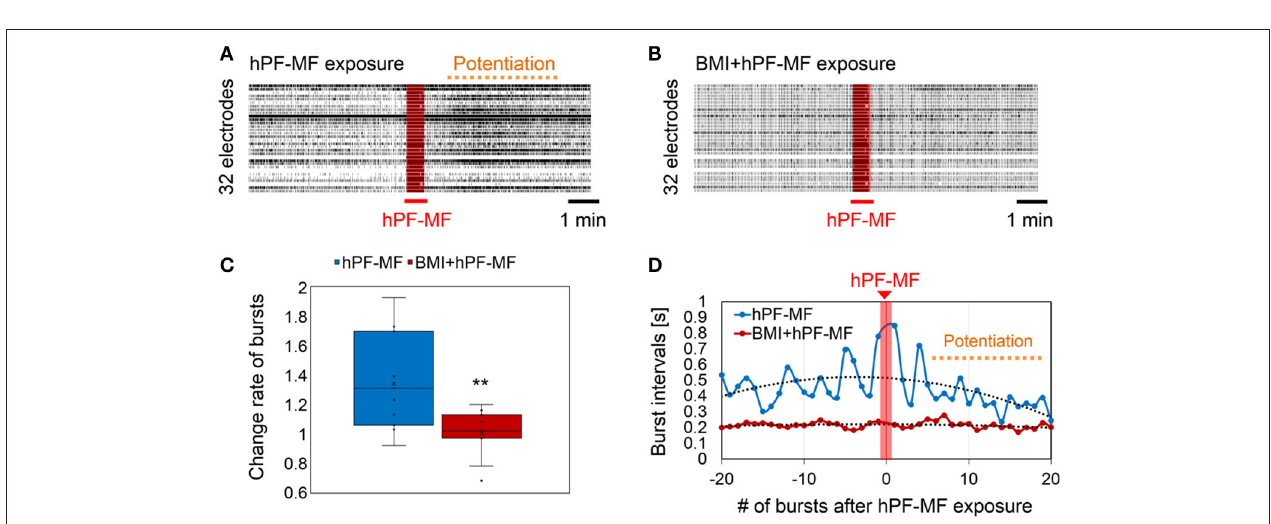
FIGURE 5 | Change in hPF-MF exposure-related neuronal modulation after inhibition of the GABA receptor by BMI. (A) Comparison of raster plot data of neuronal activity (A) before and (B) after BMI application. Potentiation of neuronal activity after the 400 mT hPF-MF exposure disappeared after BMI. (C) Comparison of the change rate of synchronized bursting activity before and after BMI application. Increase in bursting activity after 400 mT hPF-MF exposure was suppressed after BMI. (D) Comparison of the time intervals of synchronized bursting activity before and after 400 mT exposure before (hPF-MF group) and after BMI application (BMI + hPF-MF group) (before and after 20 bursts). In the hPF-MF group, the time intervals of synchronized activities varied, whereas, these fluctuations were not observed in the BMI + hPF-MF group. Furthermore, the bursting intervals in the Normal group after 400 mT hPF-MF exposure tended to approach the bursting intervals in